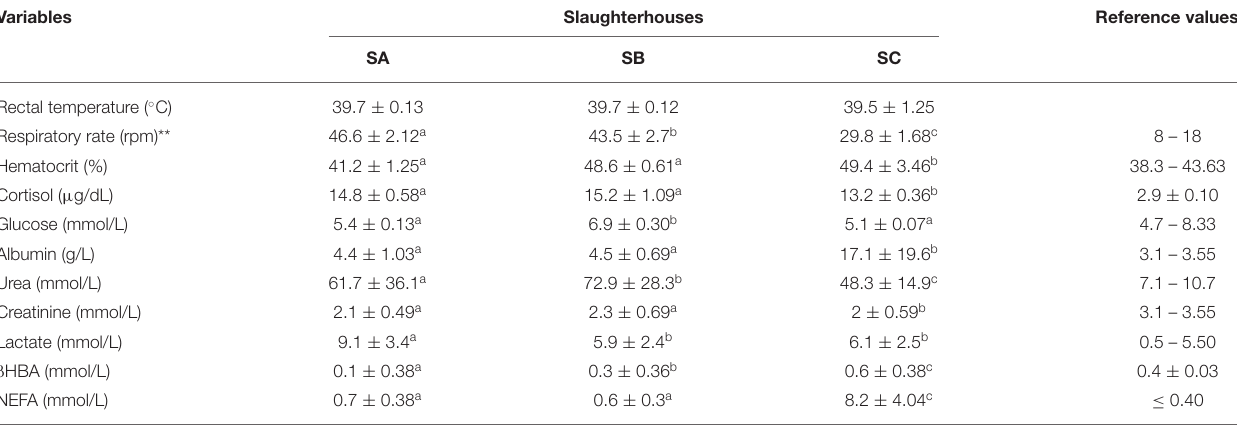
TABLE 5 | Physiological welfare indicators in blood collected from non-ambulatory pigs at three Colombian slaughterhouses. Variables